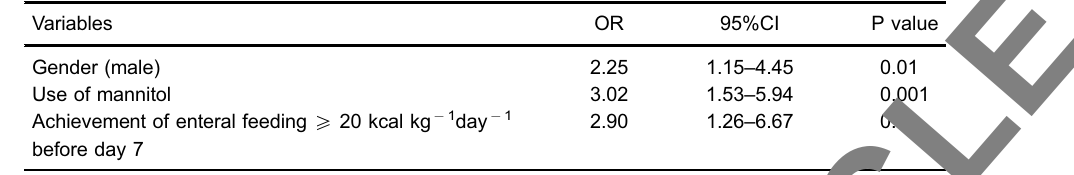
Table 2. Multivariate analysis of the risk factors for early-onset of ventilator-acquired pneumonia.